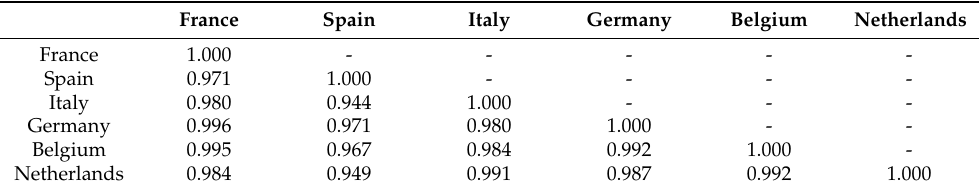
Table 7. Pearson correlation between European electricity prices (April 2020 to January 2021).